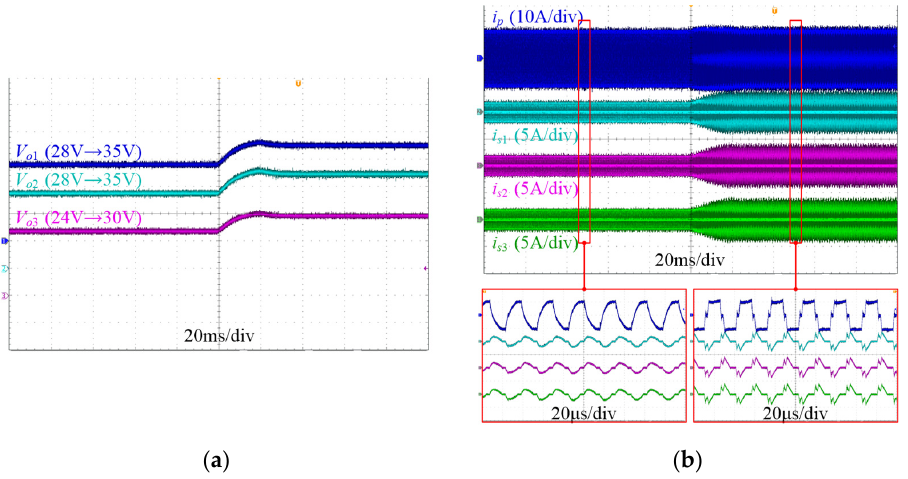
Figure 13. Experimental waveforms of input voltage change from 30 to 50 V under balanced load conditions. ( a ) Waveforms of the output voltages. ( b ) Waveforms of the current transformers.